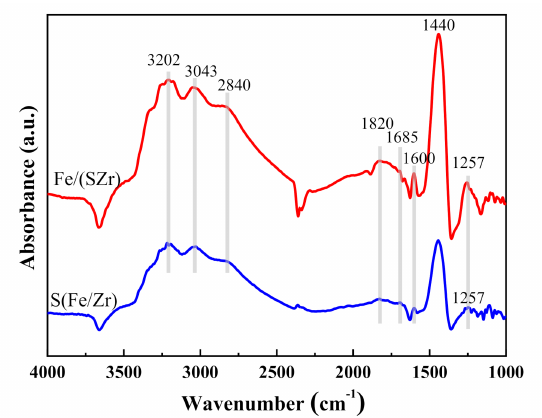
Figure 7. In situ di ff use reflectance infrared Fourier transform spectra (DRIFTS) of Fe / (SZr) and S(Fe /